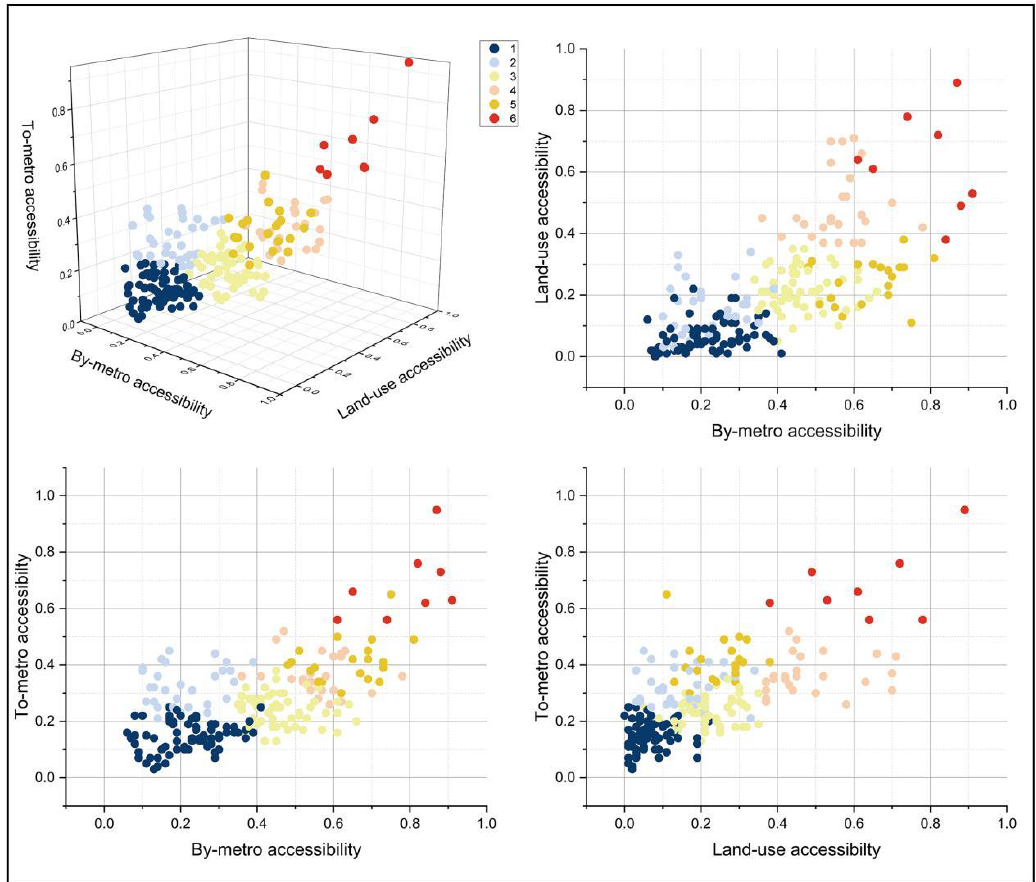
Figure 5. Classification of metro station accessibility in Wuhan.